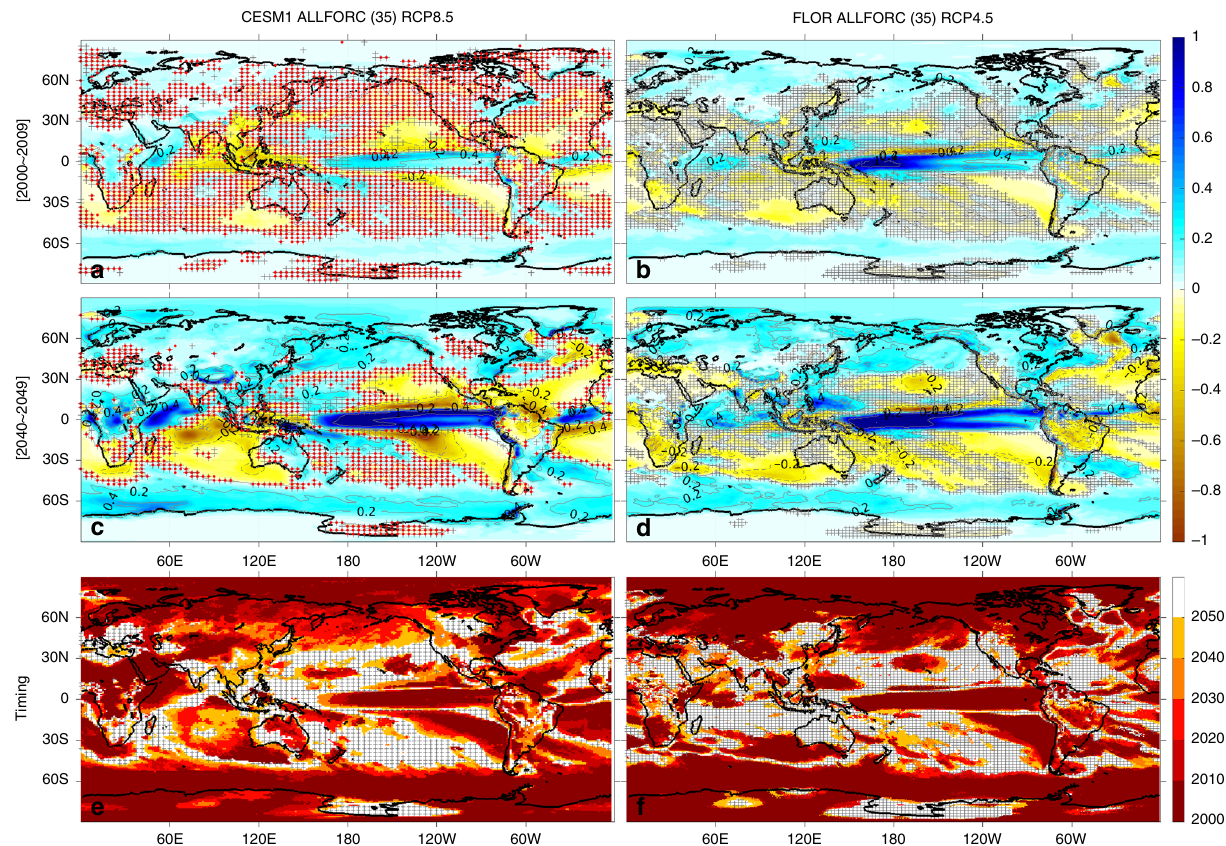
Fig. 1 Decadal evolution of annual precipitation mean state and timing of distinguishability in precipitation changes. a – d decadal evolution of changes in annual precipitation mean state (ensemble average, shading, mm day − 1 ) relative to the 1950 – 1999 climate during 2000s ( a, b ) and 2040 s ( c, d ) in CESM1 ALLFORC RCP8.5 ( a, c ) and FLOR ALLFORC RCP4.5 ( b, d ). Time goes down, as denoted to the left of the fi gure (changes during 2010s, 2020s and 2030s are shown in Supplementary Figure 3). Contours at intervals of 0.2 mm day − 1 are labeled in gray, with dashes denoting negative precipitation changes. Gray crosses in both columns denote that changes in precipitation mean state are not distinguishable from internal climate variability estimated from fully coupled control simulations (see Methods for details on the distinguishability test); red stippling in ( a, c ) denotes changes in precipitation mean state are not distinguishable from internal climate variability estimated from the atmosphere/land-only control simulation of CESM1. e, f timing of distinguishable changes in precipitation mean state in CESM1 ( e ) and FLOR ( f ), de fi ned as the fi rst decade when precipitation changes become distinguishable and